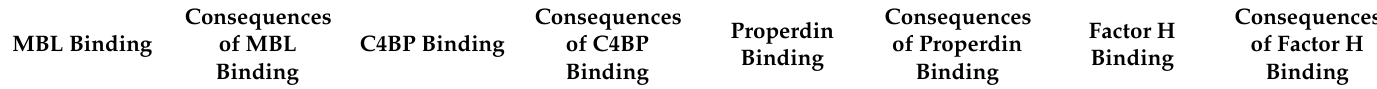
Table 1. Interaction of complement proteins to viruses, and biological